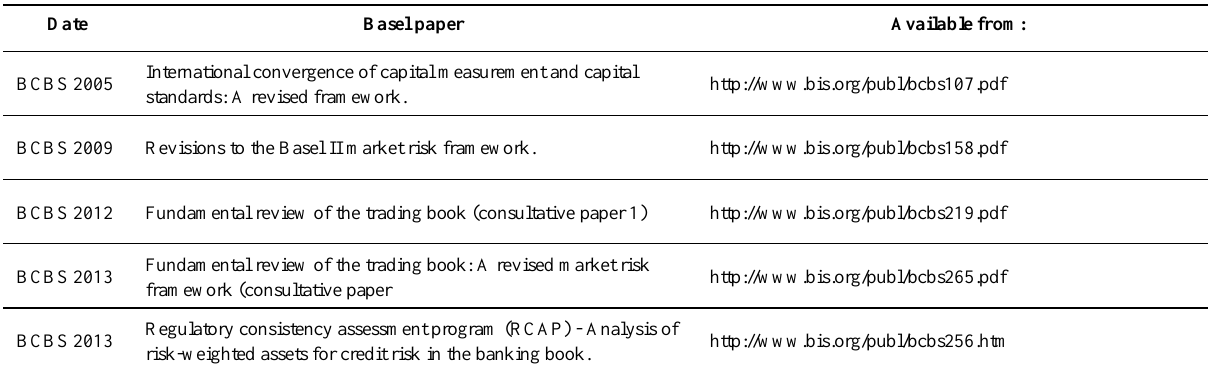
Table 1. Overview of the